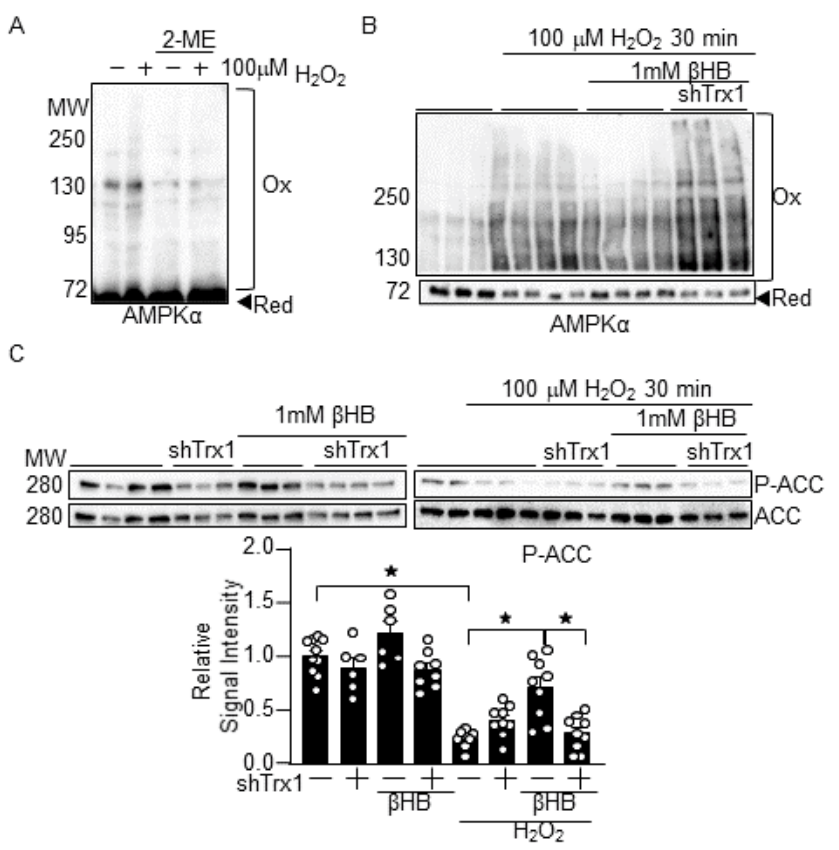
Figure 4. βHB potentiates AMPK function in a Trx1-dependent manner. ( A ) AMPKα exhibits intermolecular disulfide bond formation upon oxidation. Cardiomyocytes were treated with 100 µM H 2 O 2 for 30 min. Western blot analyses were performed following SDS-PAGE under non-reducing (without 2-ME) and reducing (with 2-ME) conditions. ( B ) βHB inhibits H 2 O 2 -induced AMPKα oxidation in a Trx1-dependent manner. ( C ) βHB normalizes H 2 O 2 -induced AMPK inhibition in a Trx1-dependent manner. n = 6–10. Western blot analyses were performed with indicated antibodies. * p < 0.05 ( C ).